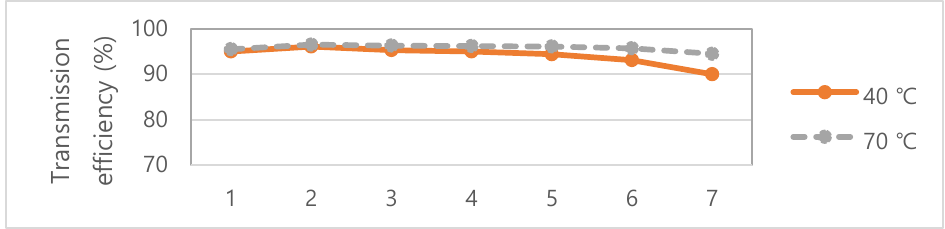
Figure 3. Average transmission efficiency at each gear speed with respect to fluid temperature .